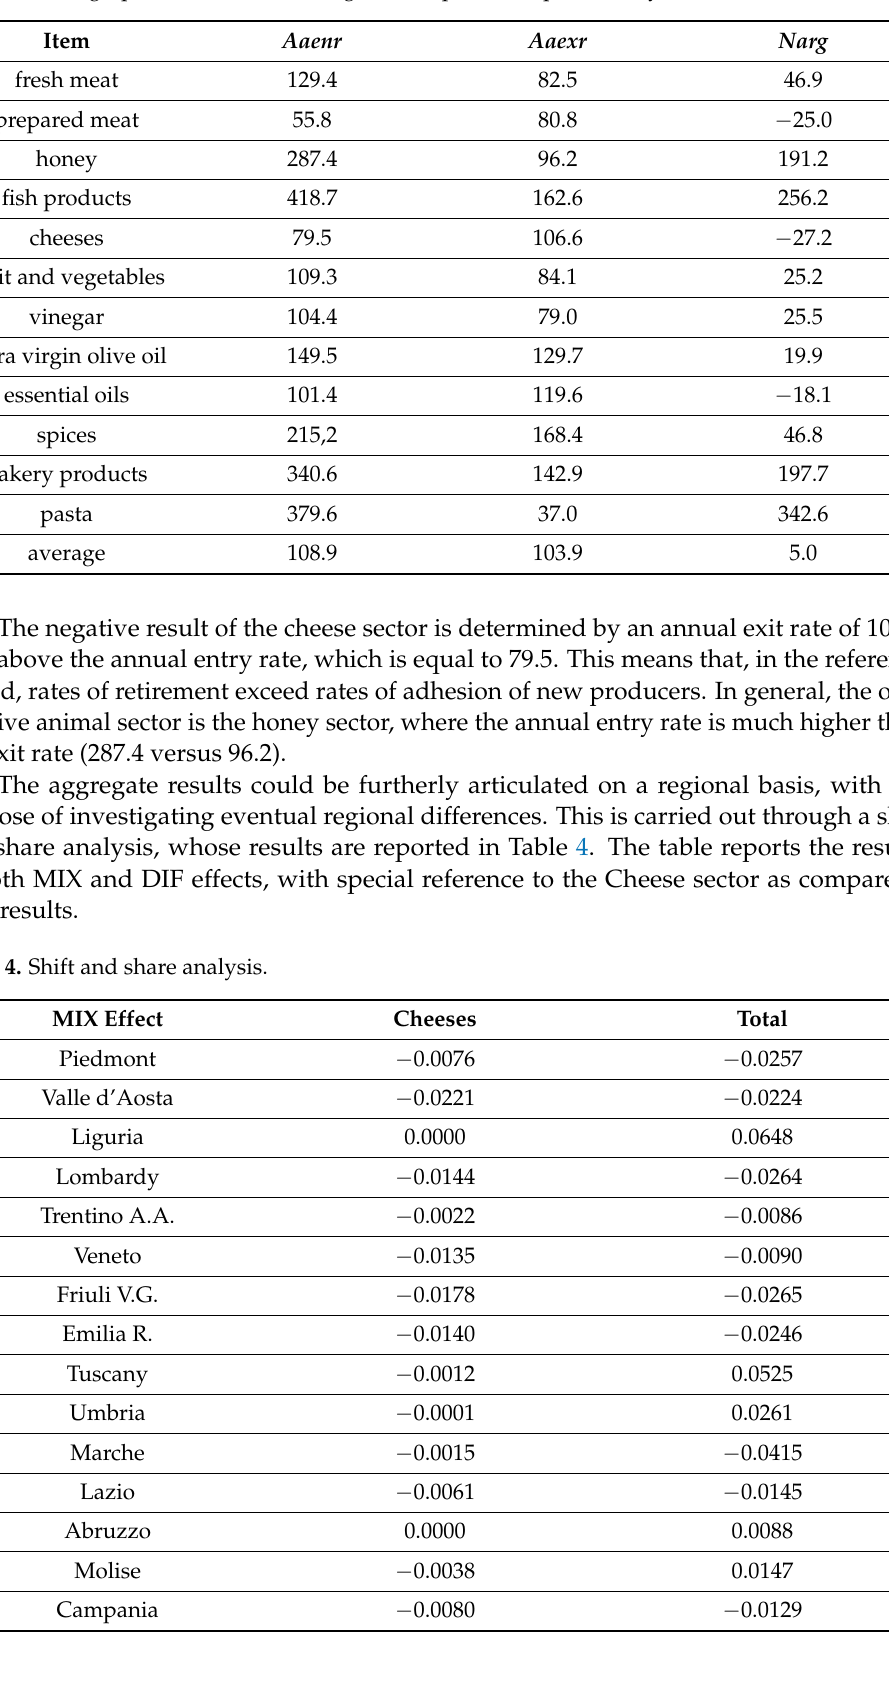
Table 3. Demographic indicators. (average means per 1000 operators—years 2010–2018).